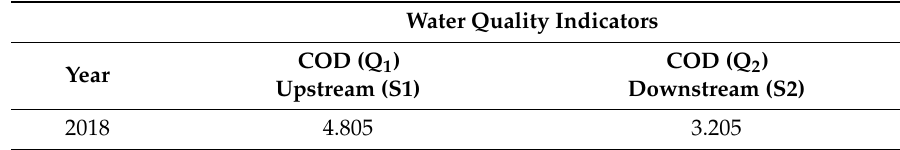
Table A1. The water quality indicators of chemical oxygen demand (COD) and NH 3 –N’s mean values of 2018 (mg / L).